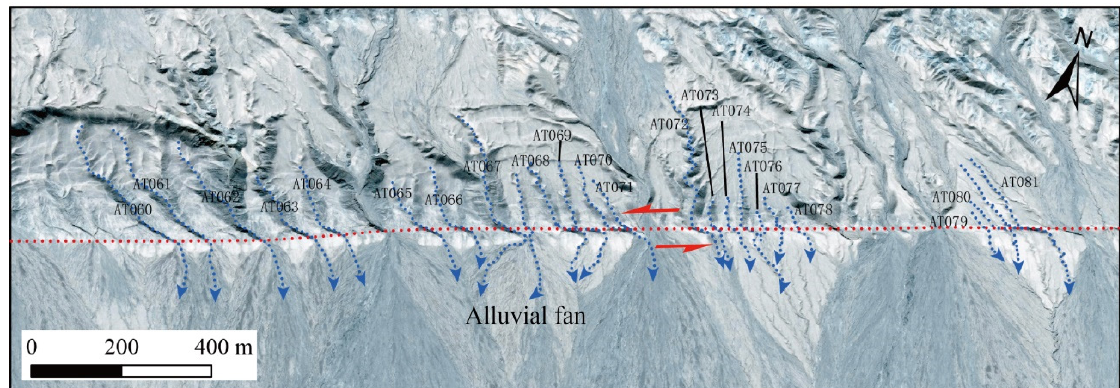
Figure 5. Systematical deflection of gullies (AT060–AT081) developed on the alluvial fan with the offset amount of a few meters to tens of meters (see Figure 1B for location, Table S1 for measurement uncertainty). Noting the capture and abandonment of stream channels associated with active faulting. The minimum offset of 7 m recorded by gully AT076 was probably generated by certain individual earthquake or multi-events. All the offsets are in meters.